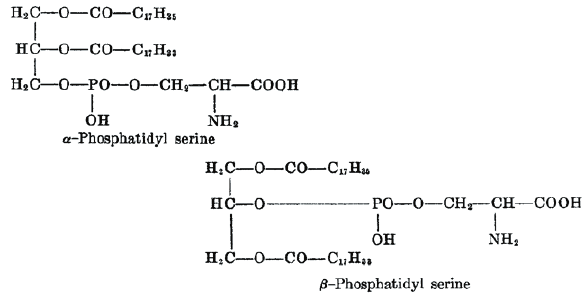
Figure 5. Many lipid derivatives were isolated, purified, and char- acterized by Professor Jordi Folch and associates from animal brain tissue in the 1940s-1950s using chloroform’s dissolving and extrac- tion properties for organic compounds. 73-80 The work of the various Folch teams marked the beginning of the lipid-chloroform scientific interaction, leading to a better understanding of brain tissue bio- chemistry. It also opened the door to many subsequent research ini- tiatives featuring the synergistic use of both